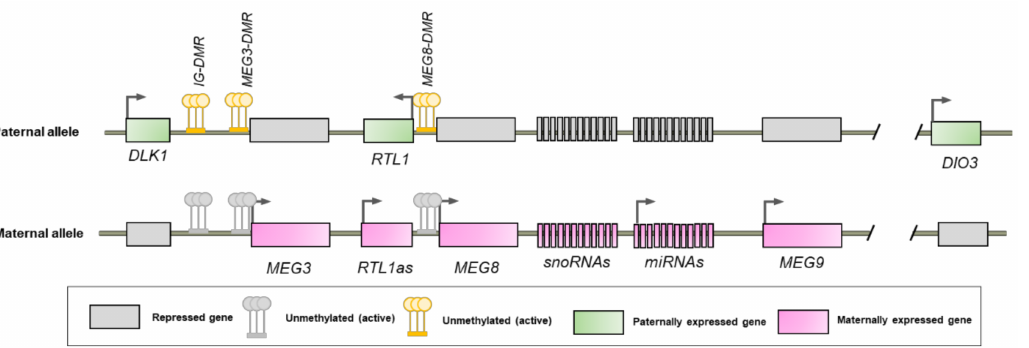
Figure 3. Schematic representation of the maternal and paternal alleles of the DLK1-DIO3 cluster.